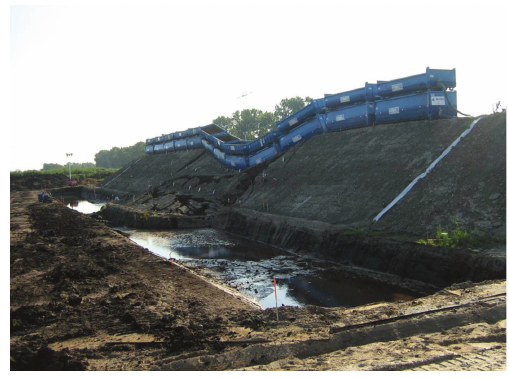
Figure 13: Levee after